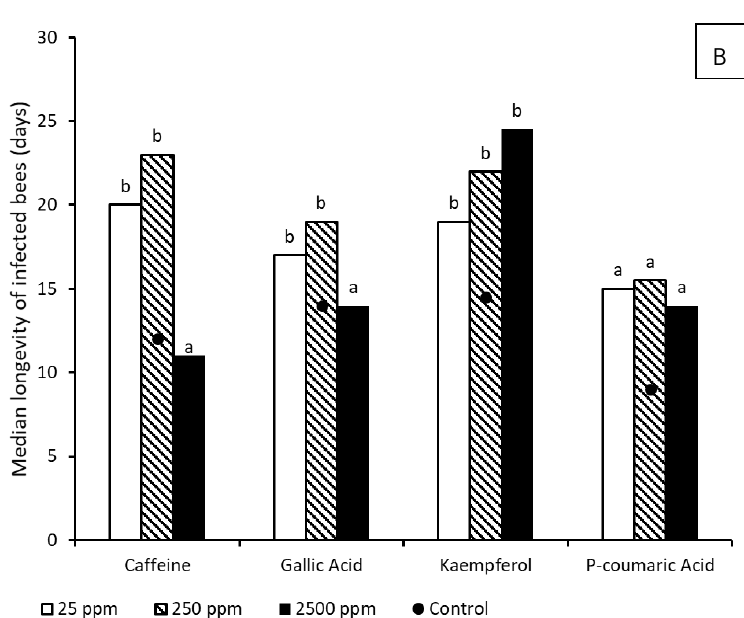
Figure 2. Spore loads (untransformed values) in dead infected bees ( A ) and median longevity of bees ( B ) that received dietary supplementation of phytochemicals at different concentrations (N = 30 bees for each phytochemical treatment; N = 22 for Control). Bars with different letters are significantly different from the control (Spore loads ( A ): GLM Univariate ANOVA followed by Tukey’s post-hoc comparison of log-transformed spore loads; Longevity ( B ): Median test).